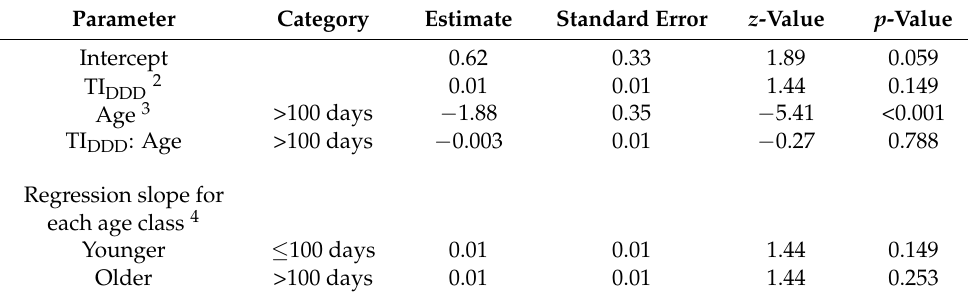
Figure 1. Probability of positive nasopharyngeal swab sample of bovine coronavirus, dependent of mean group size and age. Table 6. Results from logistic mixed regression for the detection of BCoV 1 in nasopharyngeal swab samples from 33 Swiss veal calf farms regarding TI DDD 2 and age 3 , as well as the interaction between antimicrobial treatment incidence and age. Additionally, the regression slope 4 for antimicrobial treatment incidence (i.e., the increase in BCoV prevalence with increasing daily dosage) is provided for each age 3 class